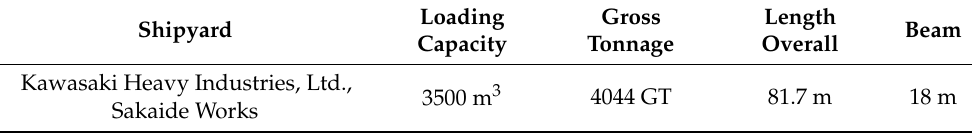
Loading Gross Length Beam Capacity Tonnage Overall 3500 m 3 4044